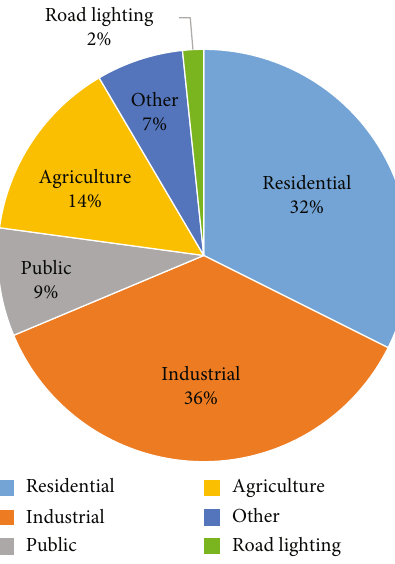
Figure 3: The share of di ff erent sectors of electricity consumption in Iran. Extracted from the Iran Grid Management Company (IGMC) database.